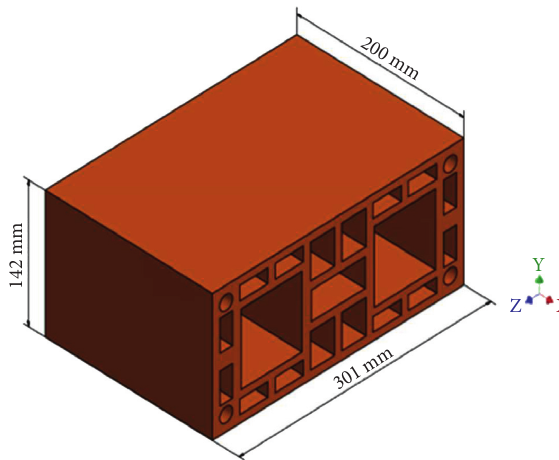
Figure 1: Schematic representation of the industrial clay brick used in this